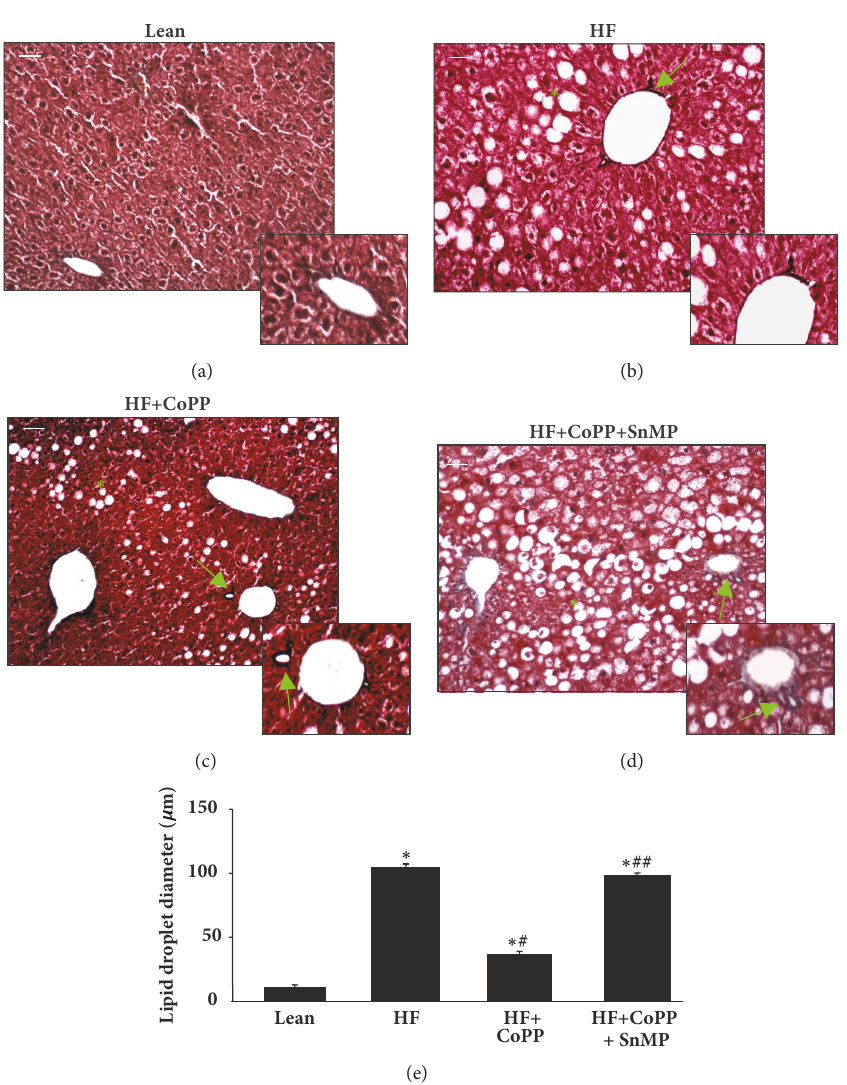
Figure 1: HO-1 induction prevents fibrosis and decreases NASH score. Liver of lean (a), HF fed (b), HF fed treated with CoPP (c), and HF fed treated with CoPP and SnMP (d) in mice and (e) graph summarizes the morphometrical analysis of liver lipid droplet diameter. ∗ p < 0.05 versus lean; # p < 0.05 versus HF fed; and + p < 0.05 versus HF fed mice + CoPP. Masson’s trichrome staining. Bar 20 𝜇 m. The arrow shows hepatic perivascular fibrosis and ( ∗ ) indicates the steatosis of control lean mice, HF fed mice, HF fed mice + CoPP, and HF fed mice + CoPP + SnMP.